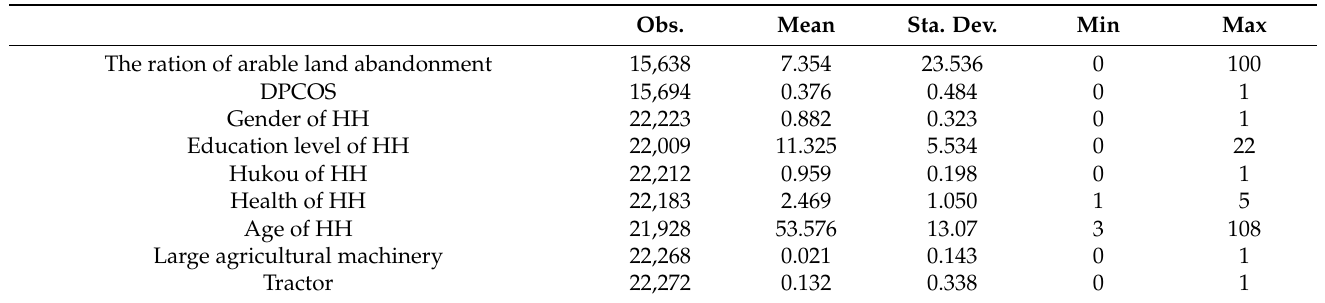
Table 2. Summary of